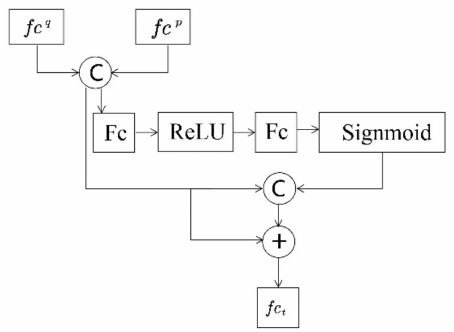
Figure 2. Feature fusion